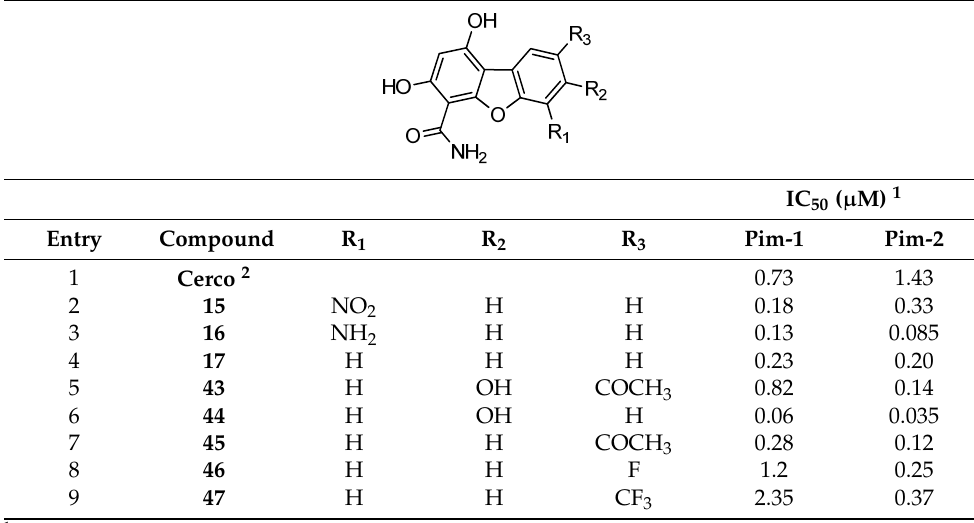
Table 2. Enzymatic assays on human Pim-1 and Pim-2 kinases (ADP-Glo method at 10 µ M ATP).